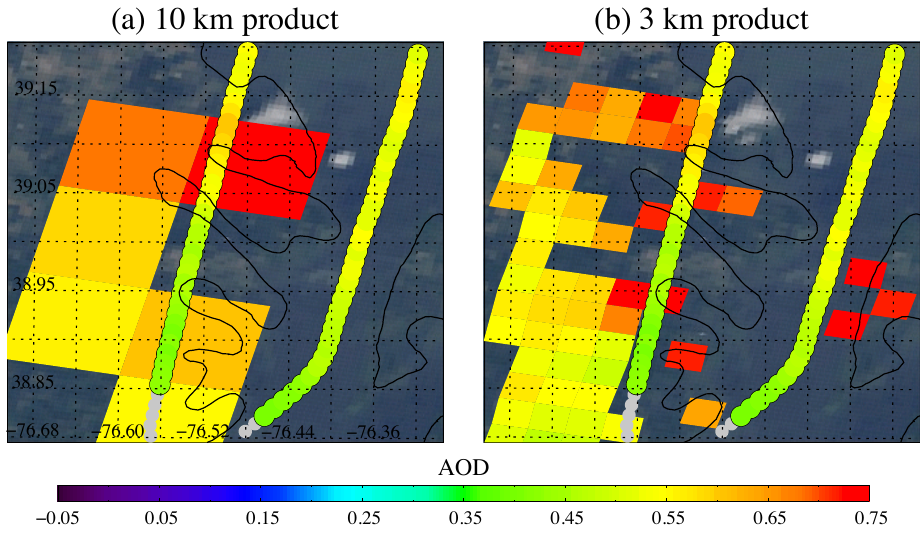
Fig. 4. Close up view of the area enclosed in the white box in Fig. 3. (a) MODIS 10km 0.55µm AOD with 532nm HSRL AOD plotted on top. (b) MODIS 3km 0.55µm AOD with 532nm HSRL AOD plotted on top.